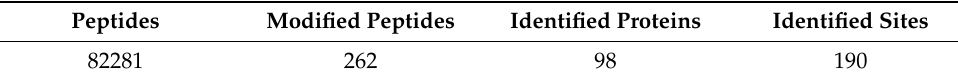
Table 1. Basic statistical table of mass spectrometry (MS)